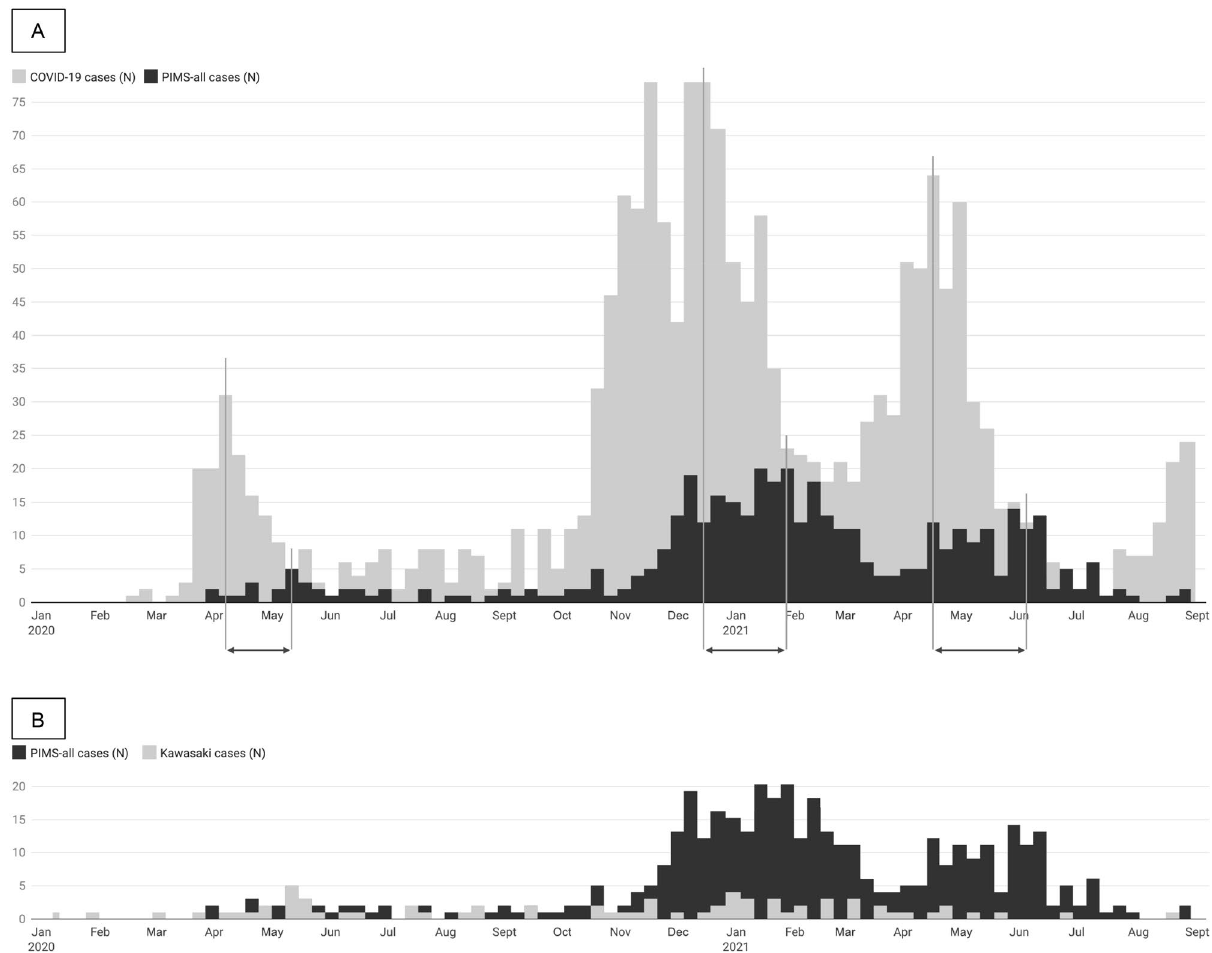
Figure 1. Weekly numbers of hospital-admitted cases of ( A ) pediatric COVID-19 and PIMS-all, as well as of cases with ( B ) PIMS-all and KD. Graphics created by using the software from www. dataw rapper. ing ascites), cardiovascular, respiratory, hematological, neurological and renal organ systems. By contrast, KD patients more commonly presented with dermatological, mucosal membrane (including conjunctivitis) and ear- nose-throat symptoms, along with cervical lymphadenopathy, arthralgias and arthritis. Unlike PIMS-non-KD, PIMS-KD patients more commonly presented with dermatological, mucosal membrane (including conjunc- tivitis) and ear-nose-throat symptoms, along with cervical lymphadenopathy, vomiting, hepatosplenomegaly and anemia. PIMS-non-KD patients more commonly had tachy-/dyspnea, pneumonia, pediatric acute respira- tory distress syndrome (pARDS), thickening of enteric walls, and nephritis. Between PIMS-all and PIMS-KD patients, there were no differences in cardiovascular presentation. In 38% and 39% of cases, respectively, PIMS-all and KD were correctly diagnosed upon admission (Sup- plementary Table 2). Among PIMS-all cases, the most important differential diagnoses upon admission were gastroenteritis, fever of unknown origin, sepsis, acute appendicitis and KD. Among KD patients, gastroenteritis and acute appendicitis were less commonly considered as potential differential diagnoses. Laboratory characteristics. No specific laboratory marker exists for either PIMS or KD. As compared to KD, however, PIMS-all patients had higher values for neutrophils, CRP, ferritin, creatinine, NT-proBNP, tro- ponin T, and d-dimers as well as lower values for hemoglobin, and thrombocytes (Table 2). By contrast, PIMS- KD showed higher titers for NT-proBNP and d-dimers than did PIMS-non-KD patients. Treatment. Median length of hospitalization was similar between PIMS-all (10d [IQR 8–12]) and KD cases (8d [IQR 6–12]), without there being any difference between PIMS-non-KD and PIMS-KD patients (Table 3). Over 90% of PIMS-all patients received a PIMS-directed therapy during their hospitalizations. Most commonly, this included immunomodulatory medication (89%), followed by systemic antibiotics (71%), hemostaseological medication (51%), pulmonary support (32%), and inotropes/vasodilators (28%). Overall, PIMS-all were more severely ill than KD patients, as indicated by a higher rate of ICU admission (48% vs. 19%), longer ICU stays (1 day [IQR 0–5] vs. < 0.5 day [IQR 0– < 0.5]), pulmonary support (32% vs. 10%), including invasive ventilation (12% and 1%, respectively), and inotropes/vasodilators (28% vs. 3%) (Table 3).